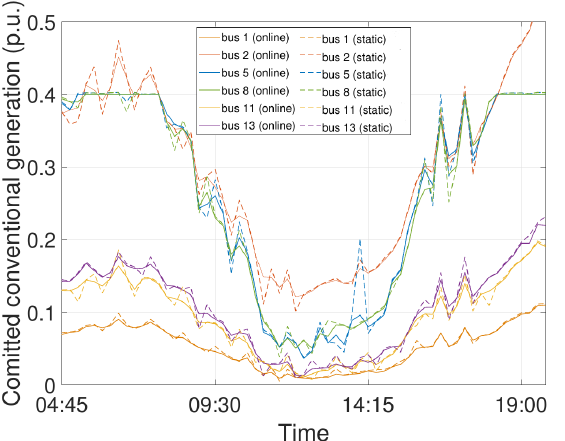
Figure 8. Conventional generation comparison between the offline [30] and online algorithms solving the distributed